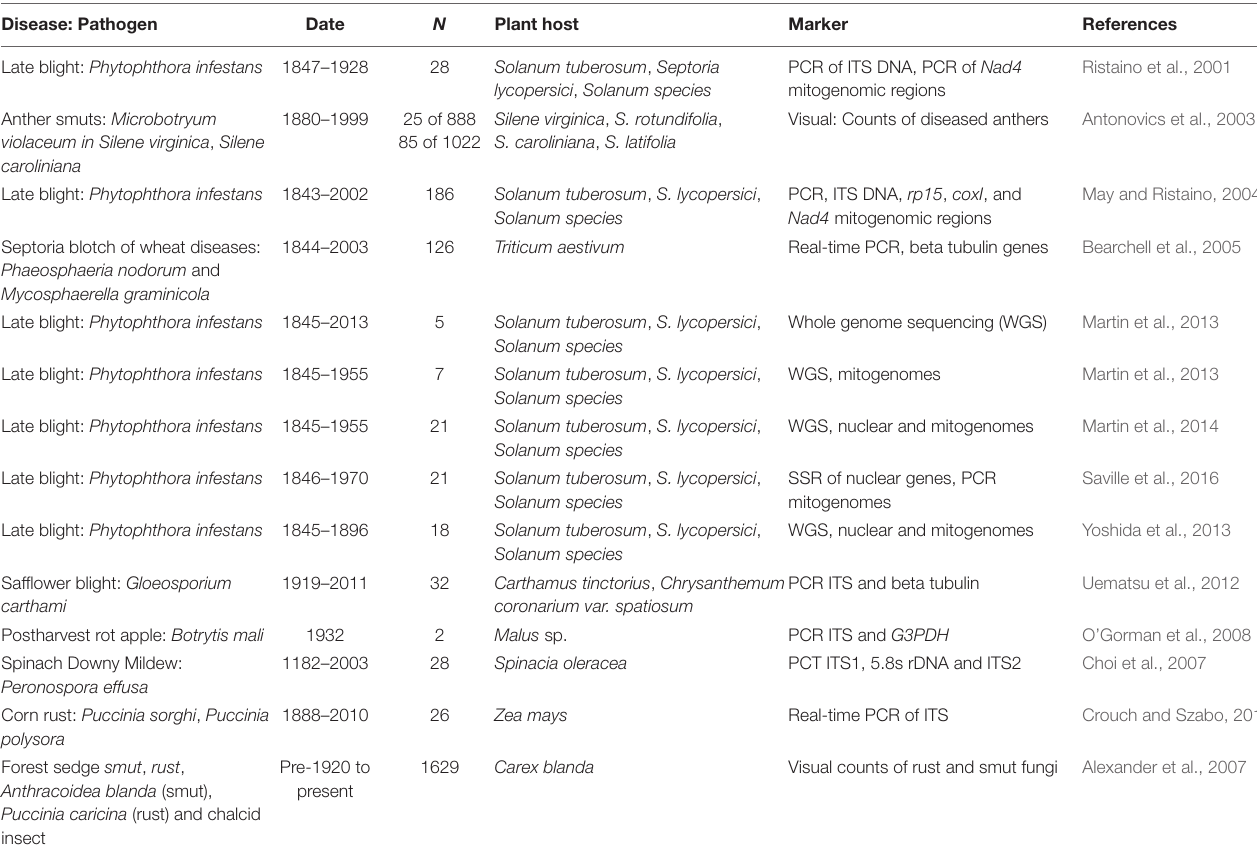
TABLE 1 | Examples of plant pathogens studied using mycological